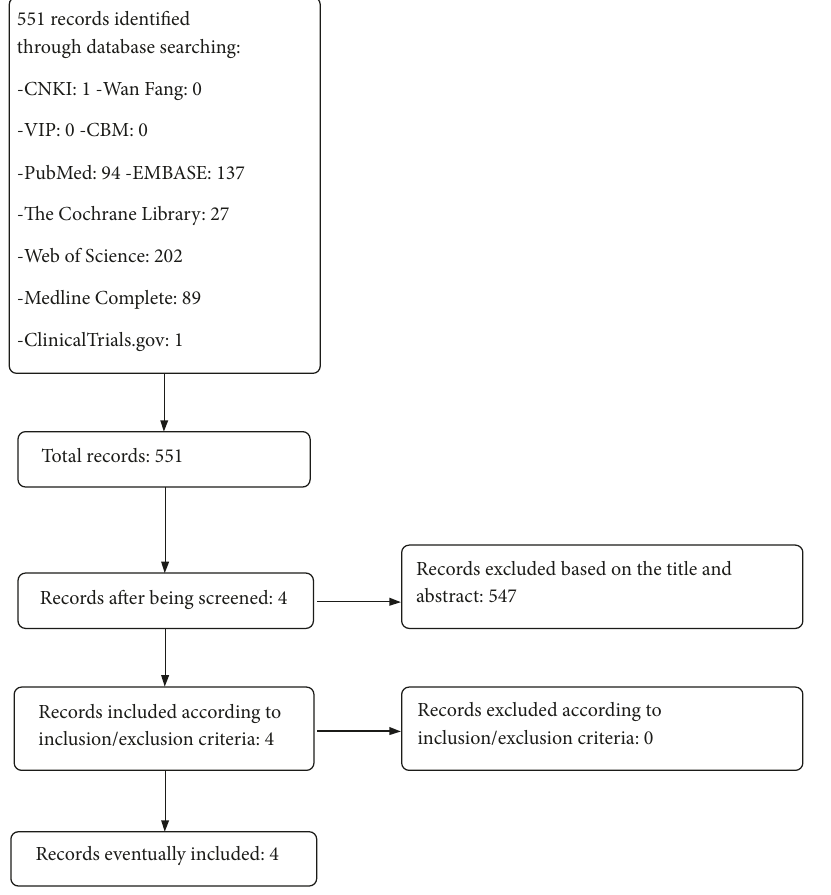
Figure 1: Flow diagram of searching and article